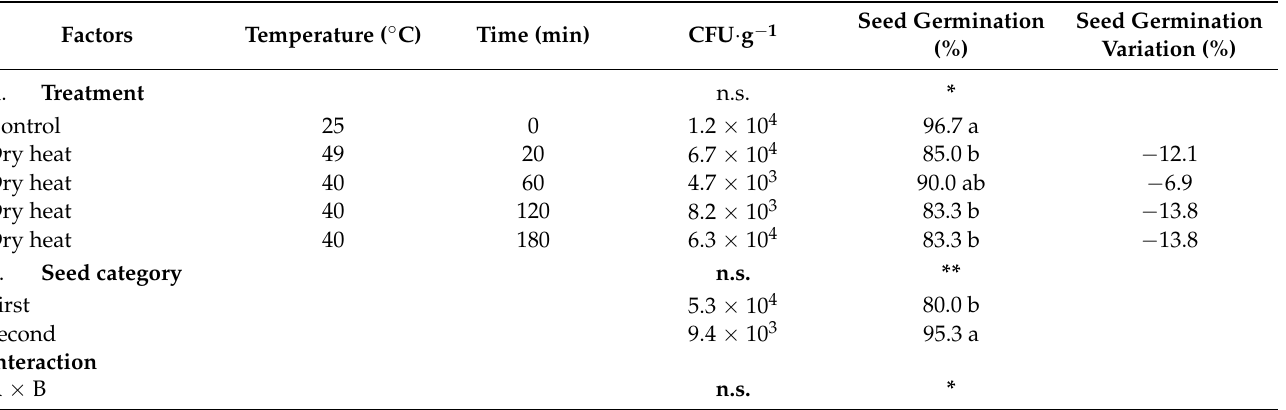
Table 4. Analysis of variance of CFU · g − 1 and seed germination (%) at the end of the second experiment with high temperatures. Dry heat was applied to garlic cloves divided in the two quality categories (first category cloves length > 15 mm, second category 10–15 mm clove length). Different letters indicate significant differences according to Tukey’s test ( p < 0.01).